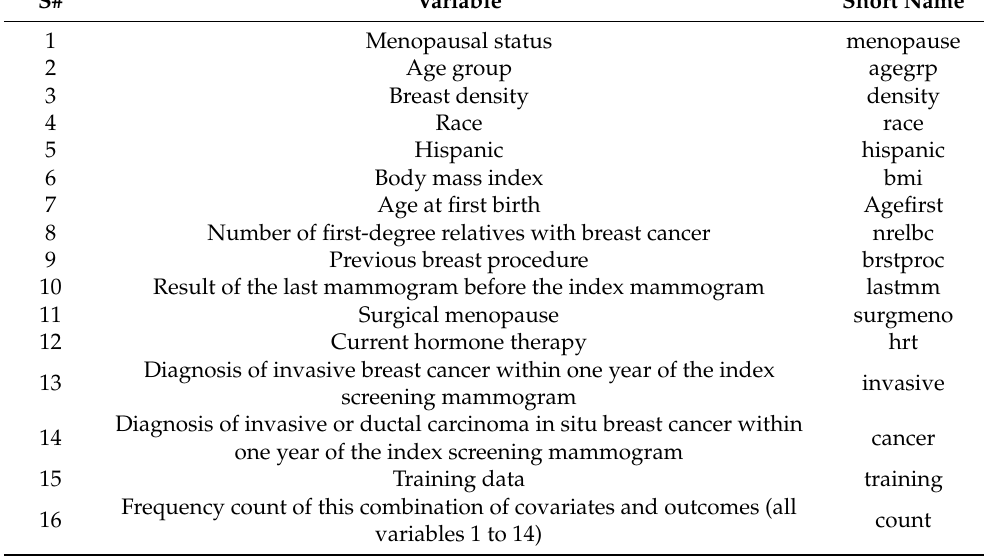
Table 4. BCSC dataset